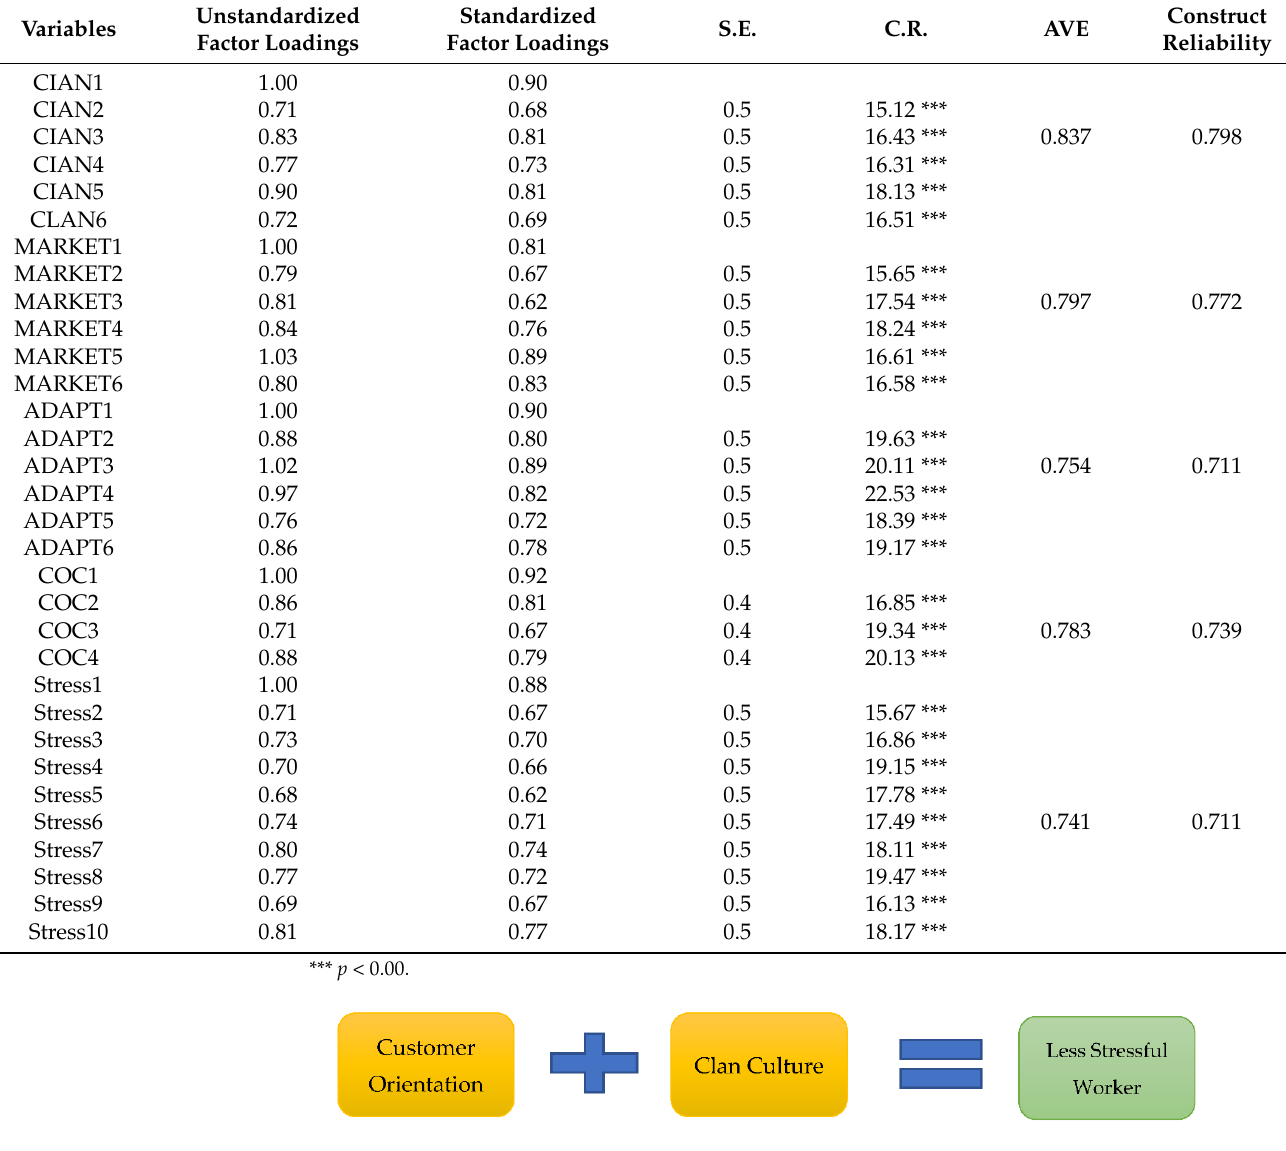
Table 8. The Statistical Results of CFA.